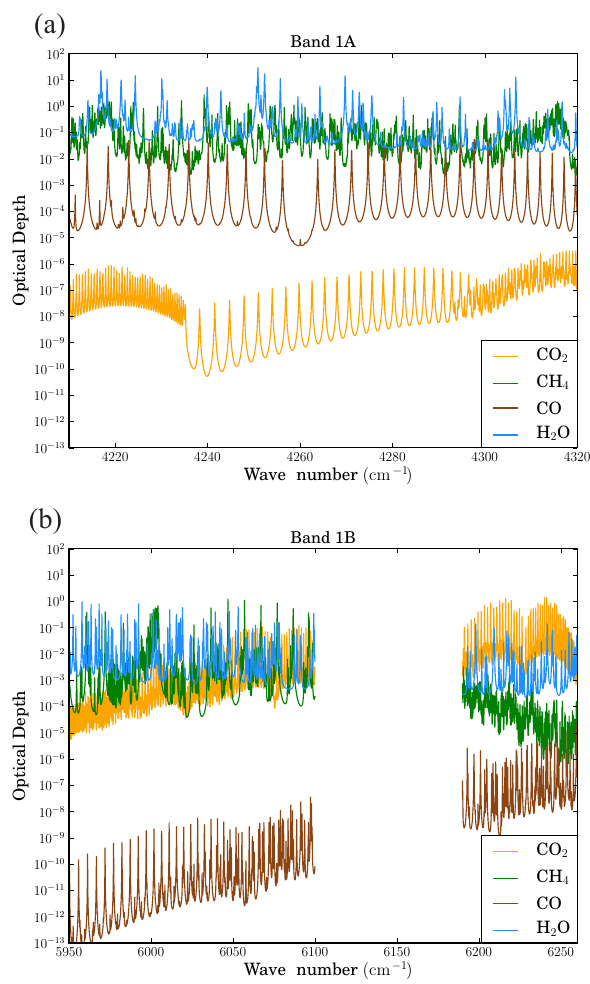
Figure 3. The optical depths of four target species in the GeoFTS spectral bands: (a) for Band 1A and (b) for Band 1B. Band 1A is for retrievals of CH 4 , CO, and H 2 O. Band 1B is for retrievals of CH 4 , CO 2 , and H 2